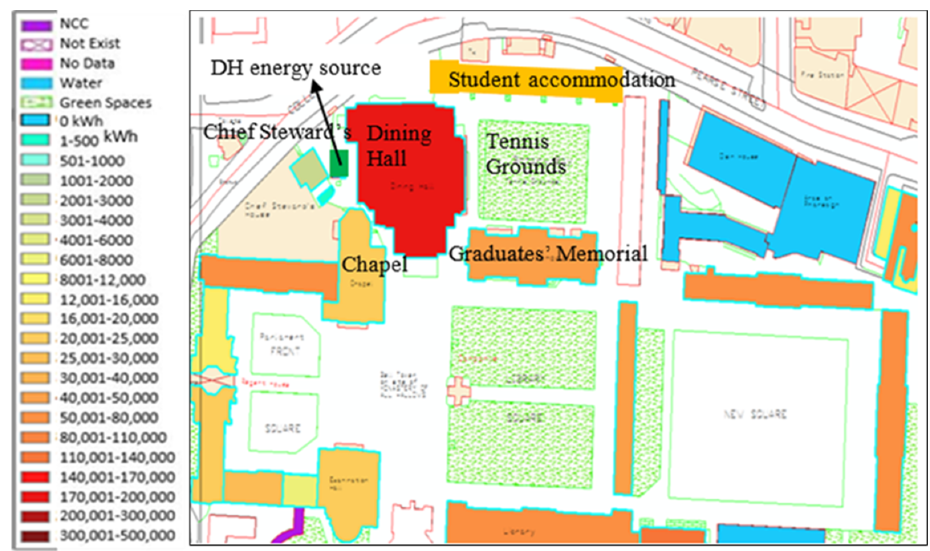
Figure 8. Location of the anchor load and heating generator in the DH system.